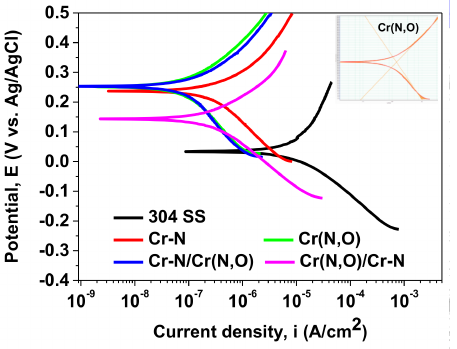
Figure 8. Tafel plots of Cr-based coatings deposited on 304 SS steel; the inset presents the fitting lines in the Tafel plot of Cr(N,O)